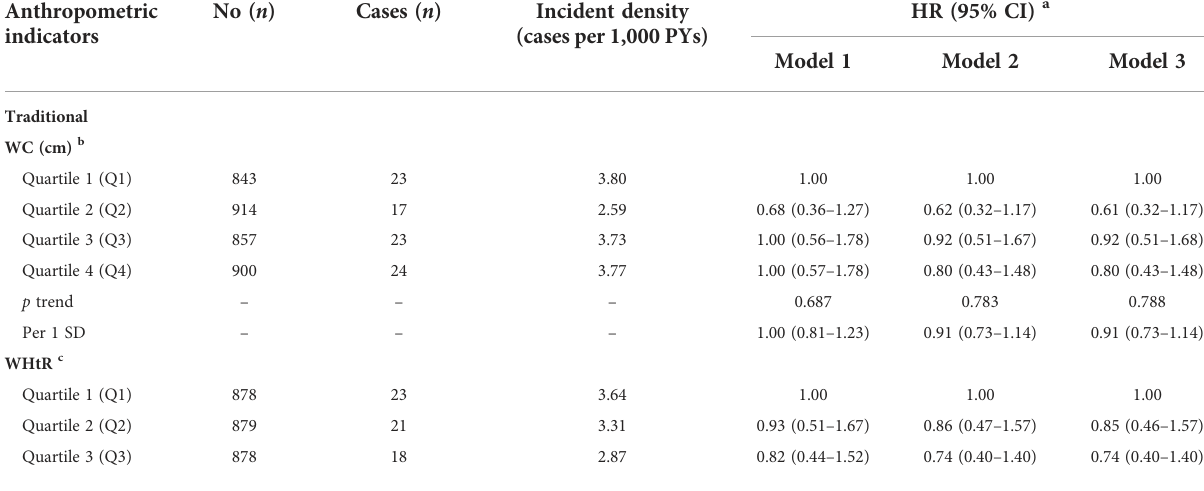
TABLE 3 Hazard ratios (HRs) and 95% con fi dence intervals (95% CIs) for overall CVDs associated with traditional and non-traditional anthropometric indicators among male participants ( n = 3,717) according to Cox regression